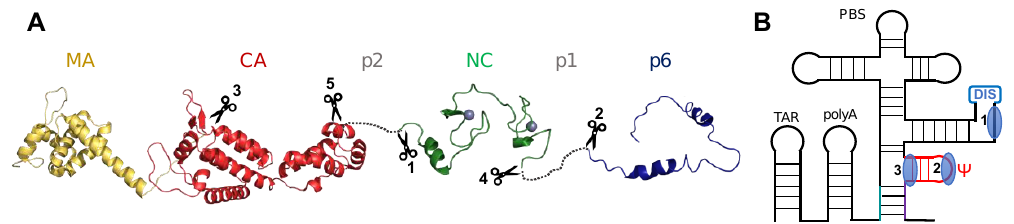
Figure 1. Organization of the Gag protein and of the 5 ′ -leader gRNA: ( A ) Juxtaposition of structures solved for the different domains of Gag (MA: PDB 1UPH, CA: PDB 3GV2, NC: PDB 1A1T, p6: PDB 2C55), the scissors indicating the cleavage sites by the viral protease and the numbers indicating the order of cleavage; ( B ) Secondary structure of the 5 ′ -leader gRNA in the dimer promoting conformation (AUG: gag translation start codon, DIS: Dimerization Initiation Site that promotes genome dimerization, PBS: Primer Binding Site for initiation of RT, polyA: polyAdenylation signal, Ψ : packaging signal hairpin, TAR: trans -Activator Response region that stimulates transcription). The main binding sites of NCp7 or the NC domain of Gag described in the text are indicated by a blue ellipse.